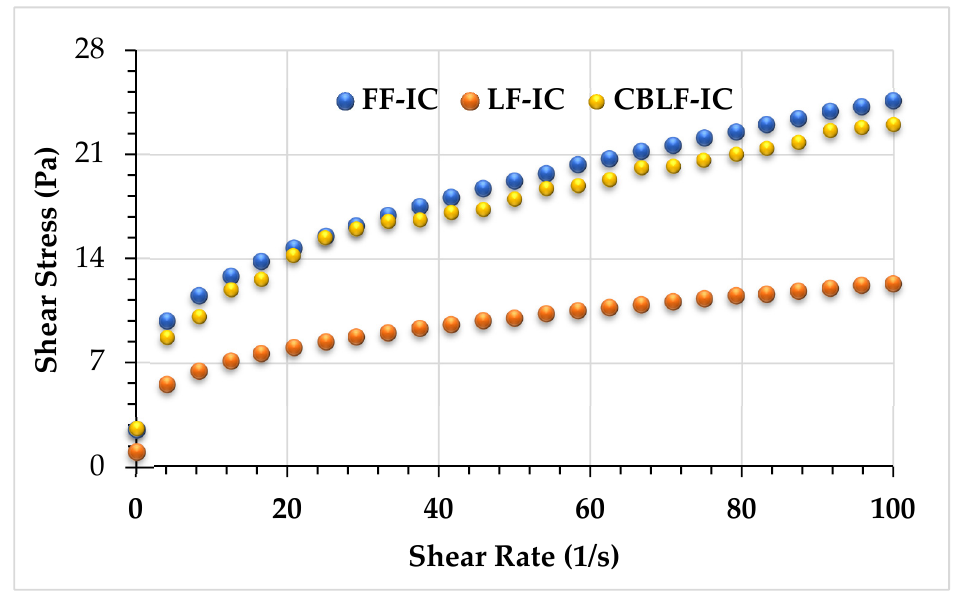
Figure 3. Steady shear rheological behavior of ice cream mixes. FF-IC: full-fat ice cream, LF-IC: low-fat ice cream, CBLF-IC: low-fat ice cream with chia seed oil by-product.